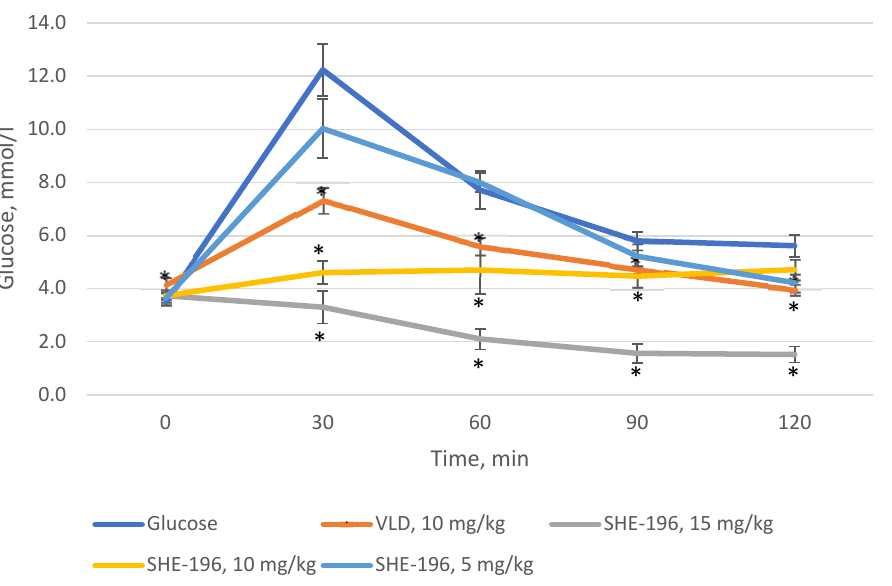
Figure 3. OGTT in C57BL/6 mice prior to the experiment with AY mice. * p < 0.05 compared to Glucose group.